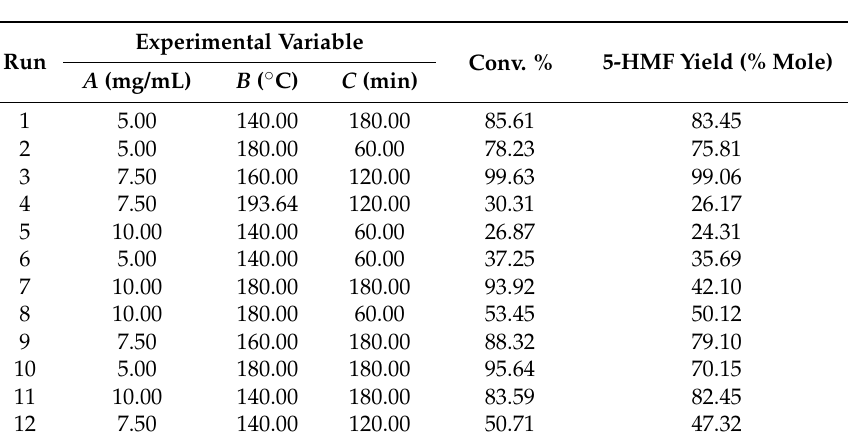
Table 6. Experimental design matrix and